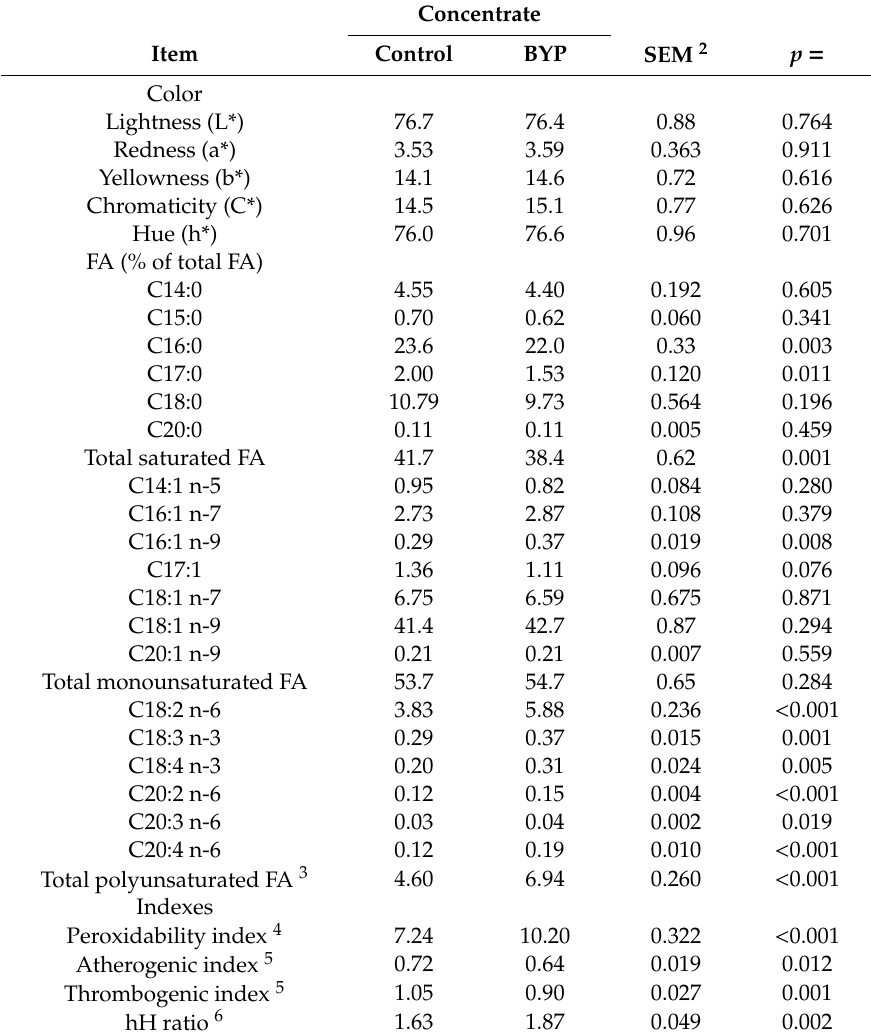
Table 6. Color parameters, fatty acid (FA) profile, peroxidation index, and indexes related to human health of the subcutaneous fat of the tail root of light lambs fed either a high-cereal concentrate (CON) or a concentrate including by-products (BYP) 1